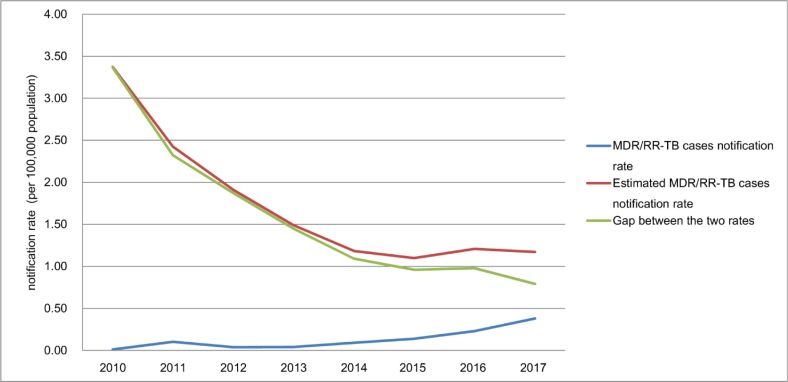
The notification gaps in new TB cases from 2010 to 2017.